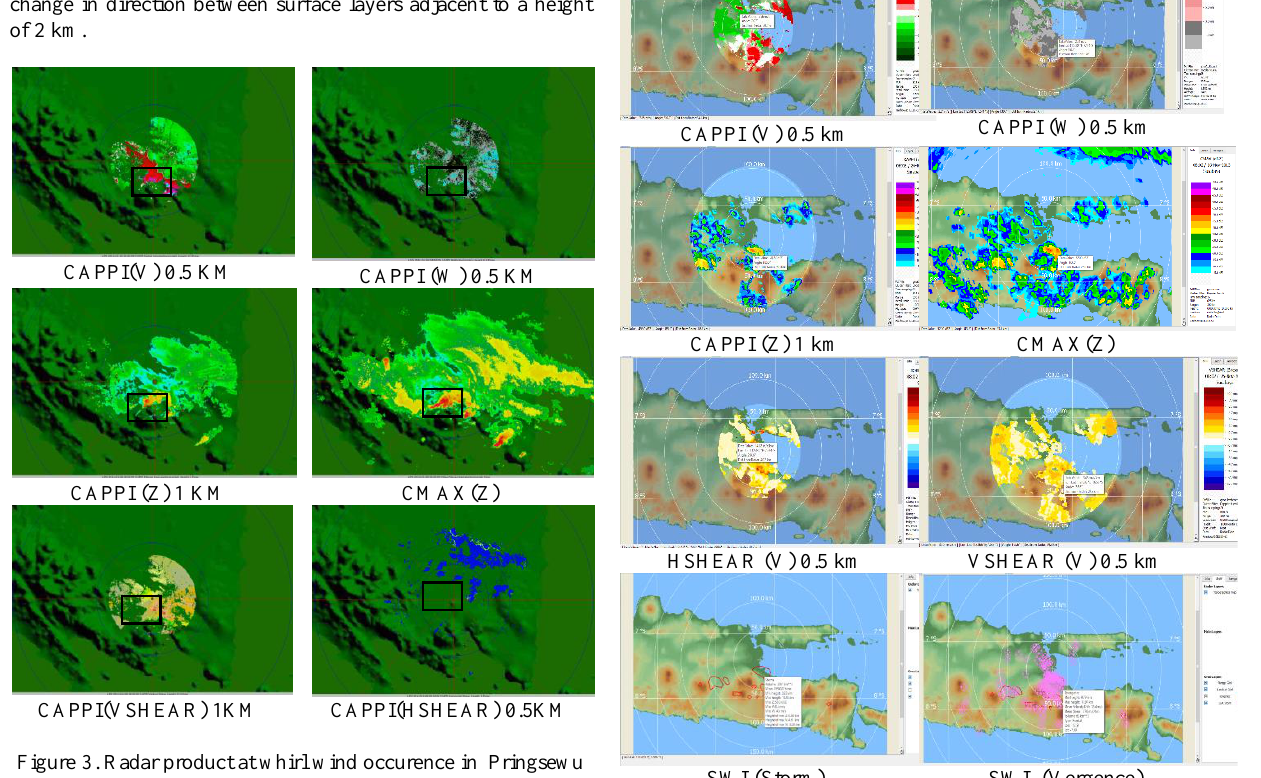
Figure 3. Radar product at whirl wind occurence in Pringsewu District, Lampung Proveince, January 8, 2014 Figure 4. Radar product at whirl wind occurence in Pasuruan, Description of the vertical wind profile VVP strengthen product analysis of CAPPI (VSHEAR) which indicates a strong vertical wind shear. At the surface layer until a layer of 1.2 km was Horizontal wind shear is detected through HSHEAR(V) 0.5 km dominated by updraft flow with a maximum value 21 ms -1 . At worth 14.12 ms -1 / km. While the vertical wind shear is detected an altitude of 2 km downdraft is detected with a value of 29 ms - through VSHEAR (V) at a height of 0.5 to 5 km by the value 1 . Updraft flow dominated from layer 2-3 km.